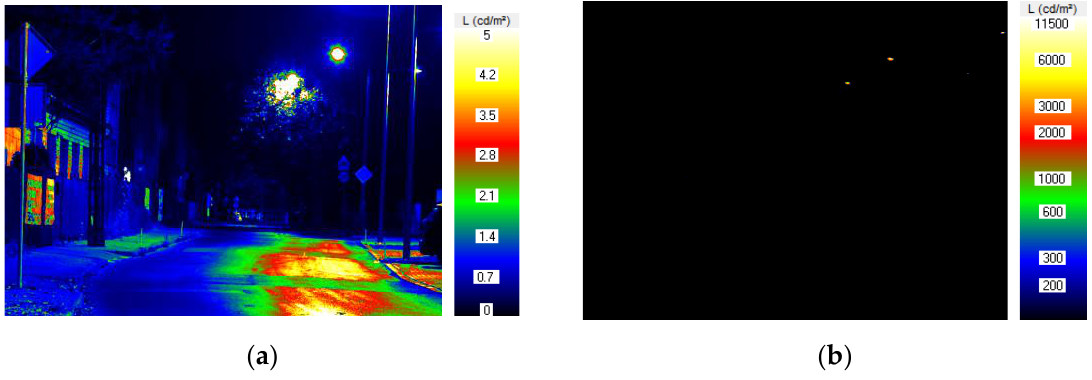
Figure 3. Measurement of road lighting, where in figure ( a ) the luminance range was selected manually and in figure ( b ), where the ILMD software matched the meter range to the maximum luminance level of the luminaires.